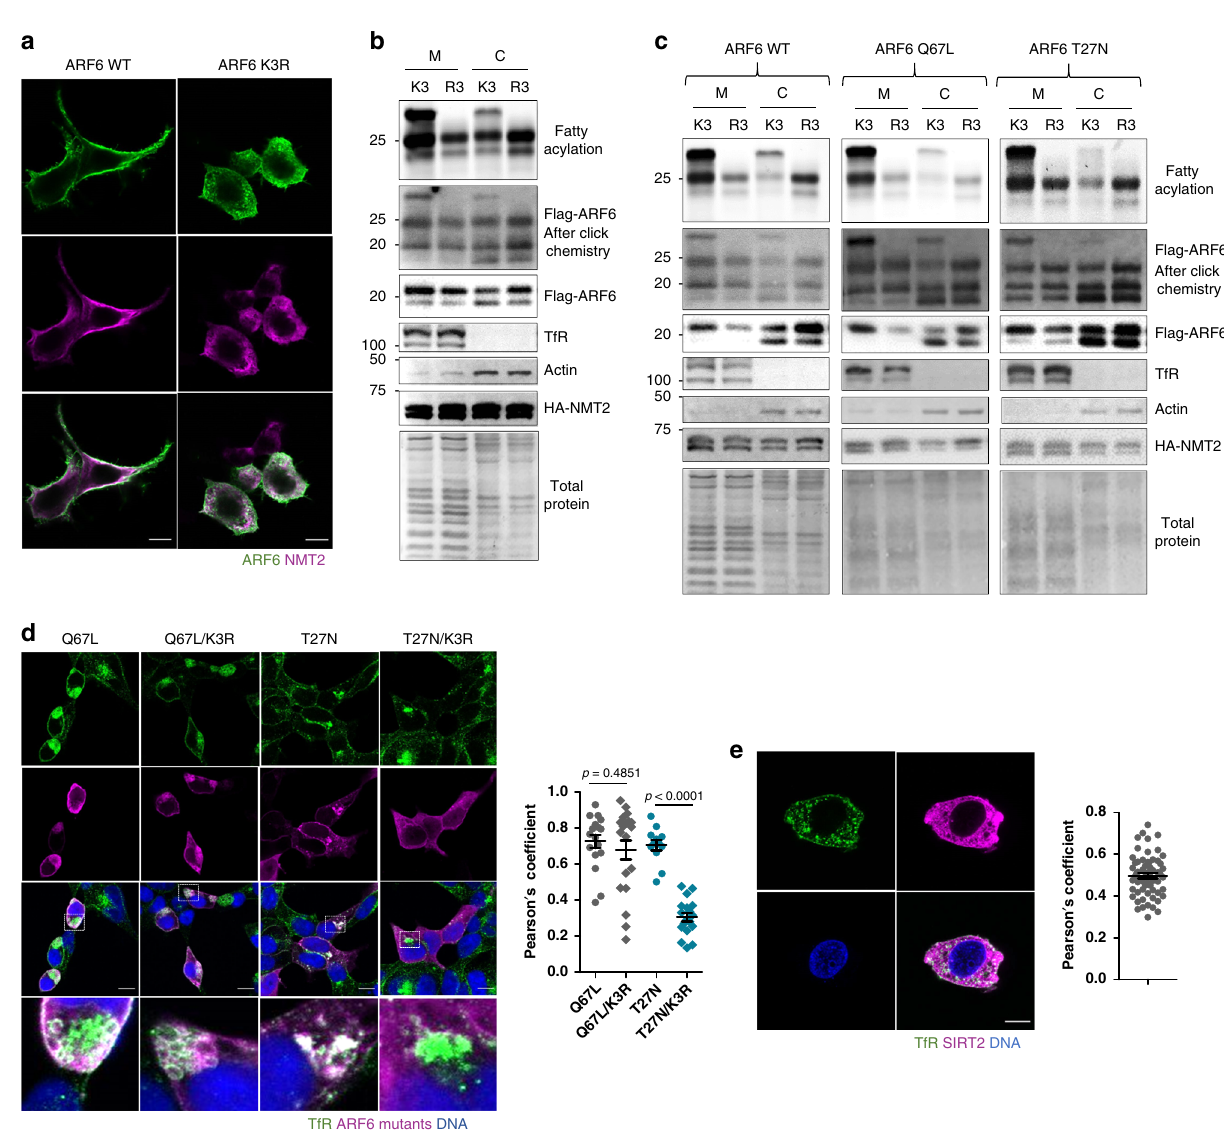
Fig. 6 Lysine myristoylation regulates ARF6 membrane localization. a Confocal microscopy of overexpressed Flag-ARF6 and HA-NMT2 showing a decreased membrane localization of ARF6 K3R compared to ARF6 WT and colocalization of ARF6 with NMT2 at the plasma membrane and cytosol but not ERC in HEK293T cells. Scale bars: 10 µ m. b Subcellular fractionation results in cells with HA-NMT2 expression and Alk12 treatment showing that K3 myristoylation promotes ARF6 membrane localization. The K3R mutant shows a decreased membrane and increased cytosolic localization compared to ARF6 WT. n = 2. c Subcellular fractionation results in cells with HA-NMT2 expression, SIRT2 KD, and Alk12 treatment demonstrating that